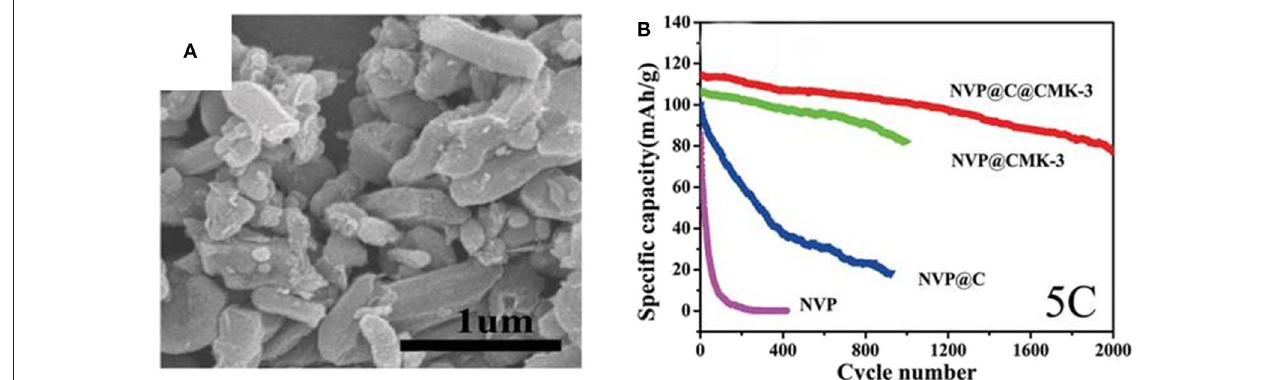
FIGURE 12 | (A) SEM image of the NVP@C@CMK-3, (B) cycle properties of the NVP,NVP@C, NVP@CMK-3, and NVP@C@CMK-3 at 5C.